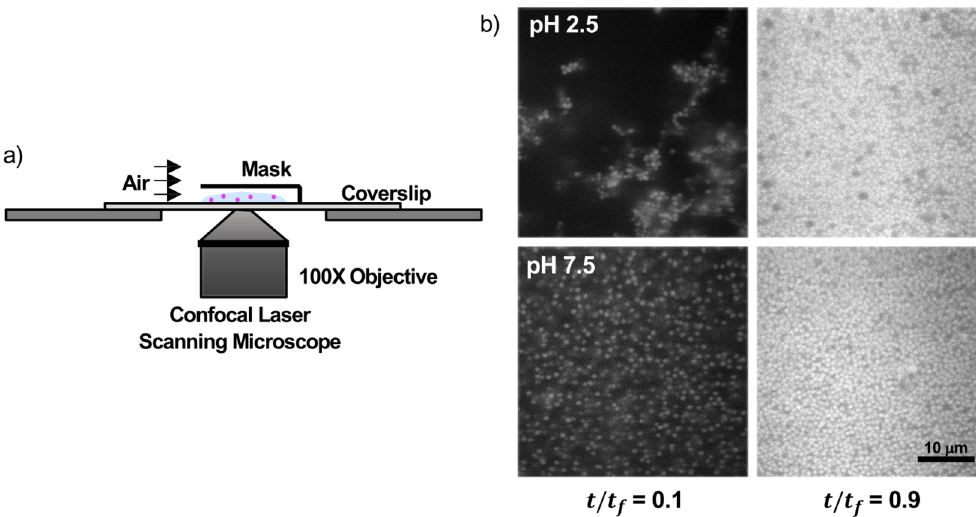
Figure 1. ( a ) Experimental setup. The blade coated sample is dried directly on the microscope under a mask that allows unidirectional drying. ( b ) Representative scans 5 μ m above the substrate early and late in